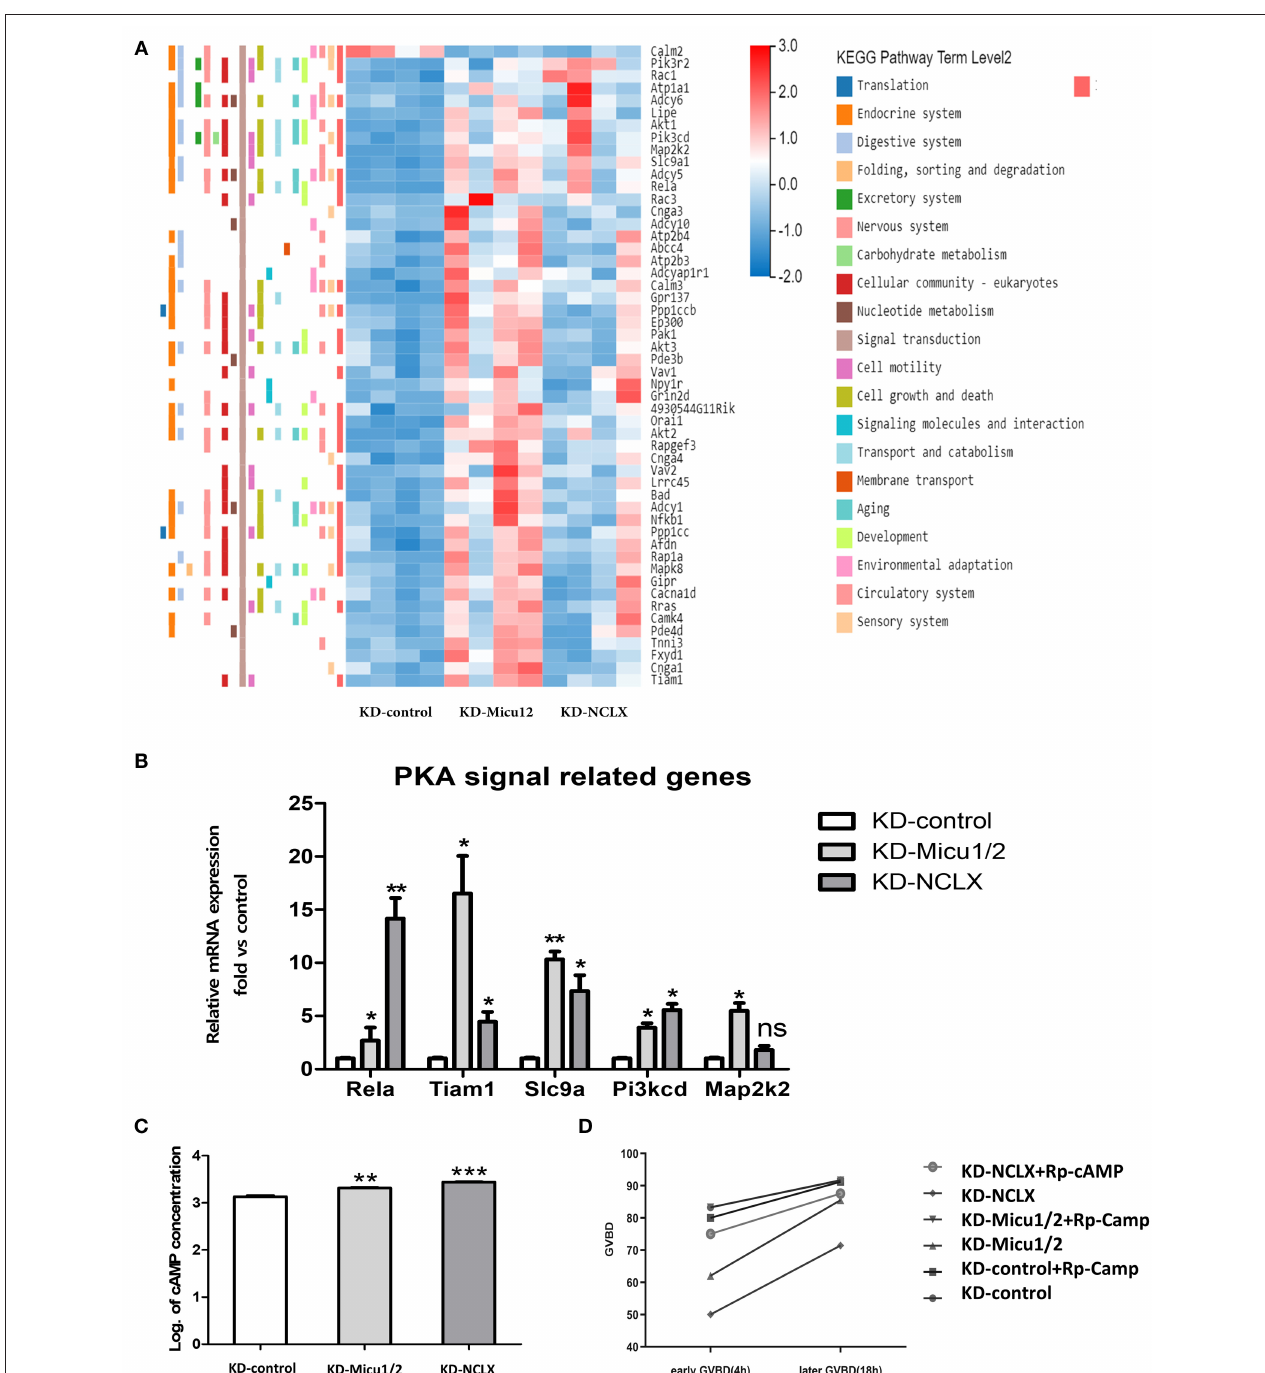
FIGURE 5 | Mitochondrial Ca 2 + overload leads to meiotic delays which may related to impairing PKA signaling. (A) Heatmap showing the average expression for all replicates and relative expression between replicates for genes with PKA signal pathway (based on GO term). (B) Dysregulation of genes associated with PKA pathway signaling in KD-control, KD-Micu1/2, and KD-NCLX oocytes ( n = 30 for each group). (C) Quantification of the relative levels of cAMP in oocytes. ( n = 40 for each group). (D) Percentage of GVBD at 2.5h and 18h after milrinone removal for oocytes treated with or without Rp-cAMP. ( n = 24 for KD-control, n = 30 for KD-control + Rp-cAMP, n = 24 for KD-Micu1/2, n = 24 for KD-Micu1/2 + Rp-cAMP, and n = 40 for KD-NCLX, n = 32 for KD-NCLX + Rp-cAMP). Student’s t- test and one-way ANOVA were utilized for statistical analyses. * P < 0.05, ** P < 0.01, *** P < 0. 001; ns, non-significant ( P > 0.05). Error bars indicate SEM.